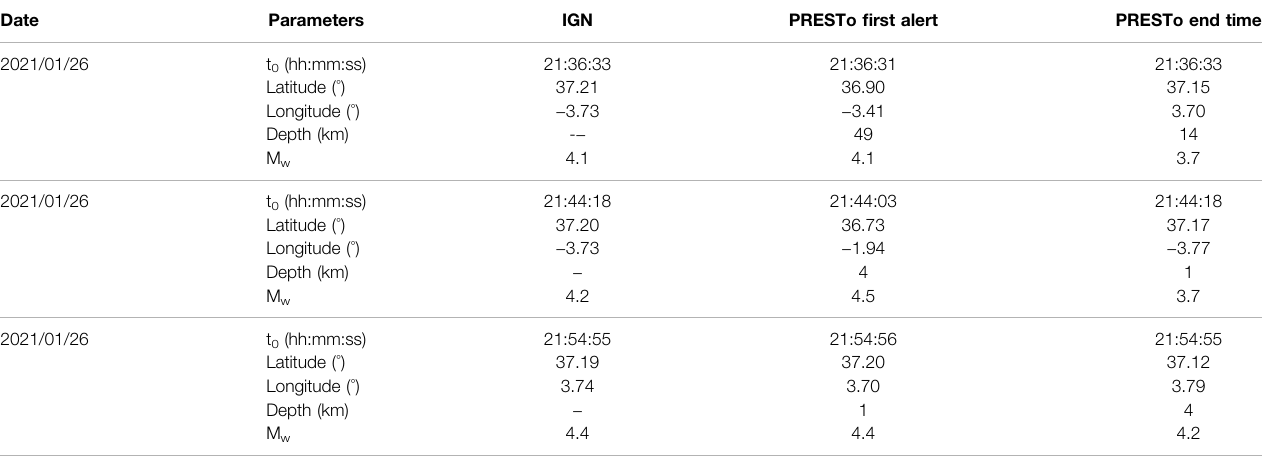
TABLE 1 | Origin time, hypocentral location, and magnitude obtained by IGN and PRESTo ( fi rst alert and end time) for the Granada 2021